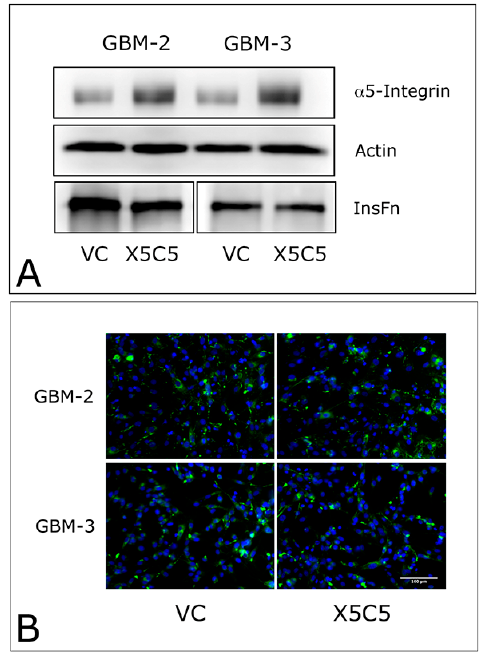
Figure 2. Overexpression of α 5 integrin fails to promote FNMA in GBM cells. Immunoblot ( A ) and immunofluorescence ( B ) analysis of FNMA by integrin (X5C5) transfected GBM-2 and GBM-3 cells shows no appreciable increase in the production of an insoluble fibronectin matrix (InsFn) relative to empty vector controls (VC). Green signal (assembled fibronectin matrix), blue signal (DAPI counterstain).